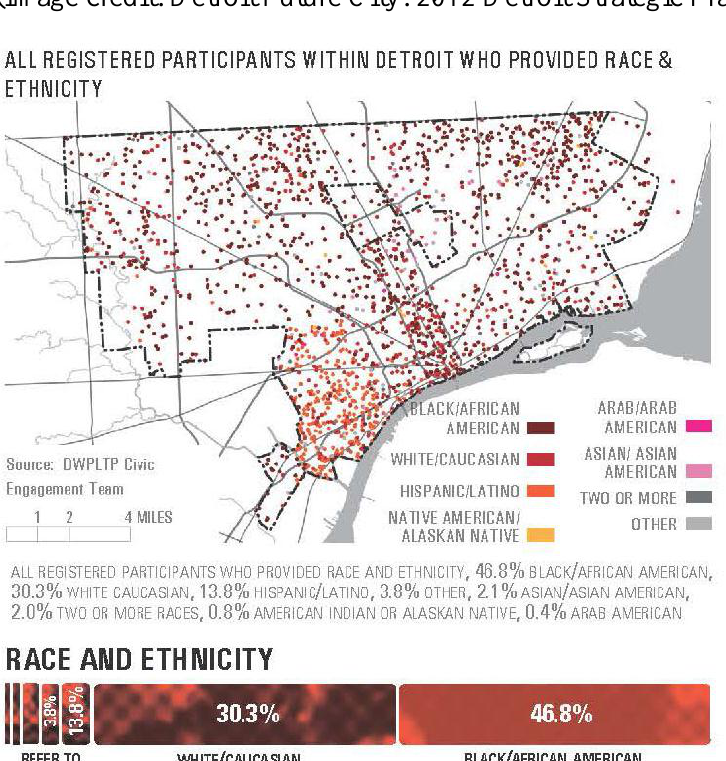
Figure 7. Map of all registered participants of DWPLTP within Detroit who provided race and ethnicity. (Image credit: Detroit Future City: 2012 Detroit Strategic Framework Plan).